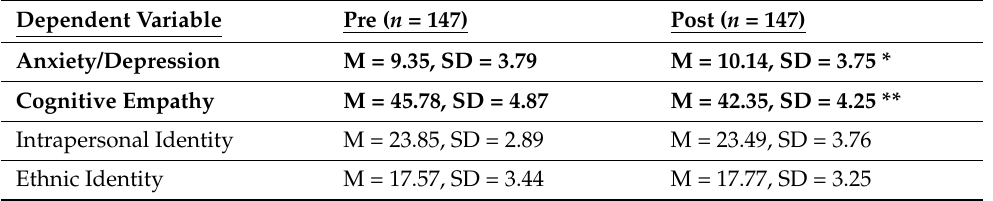
Table 2. Descriptive